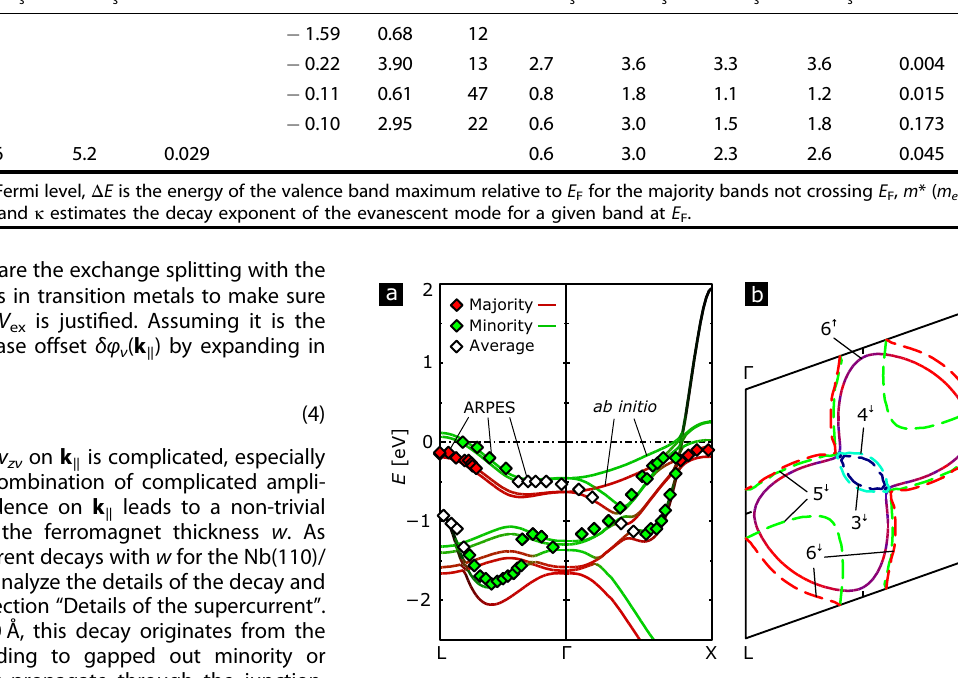
Fig. 4 Band structure. a Electronic band structure of bulk Ni (solid lines) calculated from fi rst principles including many-body effects, see ref. 46 . It is the highest- fi delity available and is very close to ARPES data (diamonds) in both majority (red) and minority (green) spin bands, with exchange splitting V ex = 0.3 eV. b Majority (solid line) and minority (dashed line) Fermi surfaces of bulk Ni in the k ∥ plane (with k z = 0) corresponding to the (111) plane direction used for the stacking of the Nb/Ni/Nb junctions, as discussed in the text. Axes correspond to two Γ -L lines: the Fermi surface has a threefold symmetry in the entire plane. Majority band 6 ↑ is depicted as a solid red-blue line with color interpolating between red and blue depending on the Fermi velocity ℏ − 1 ∂ E / ∂ k , which ranges between 3 × 10 5 m/s (red) and 6 × 10 5 m/s (blue). Minority bands are shown by dashed lines: 3 ↓ (blue), 4 ↓ (cyan), 5 ↓ (green), and 6 ↓